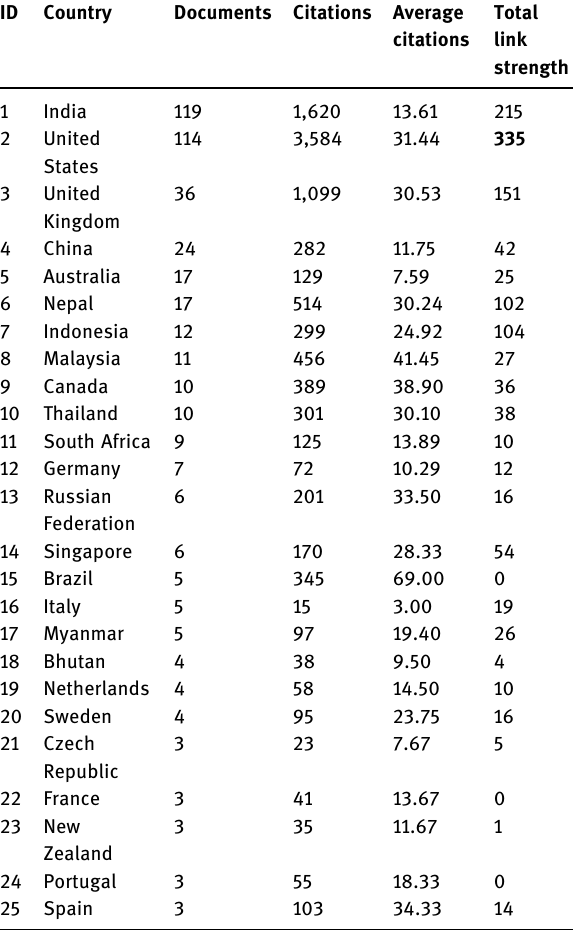
Table 1: Top countries publishing research studies on wildlife conservation ID